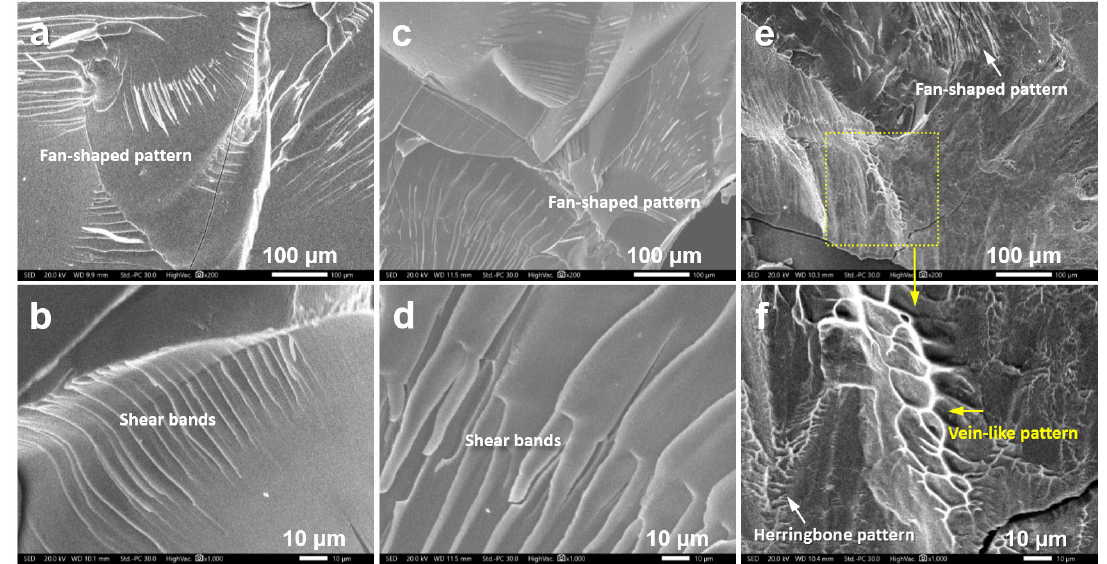
Figure 8. SEM images of fracture morphologies of the experimental alloys: ( a , b ) Sample 6; ( c , d ) Sample 7; ( e , f ) Sample 8.